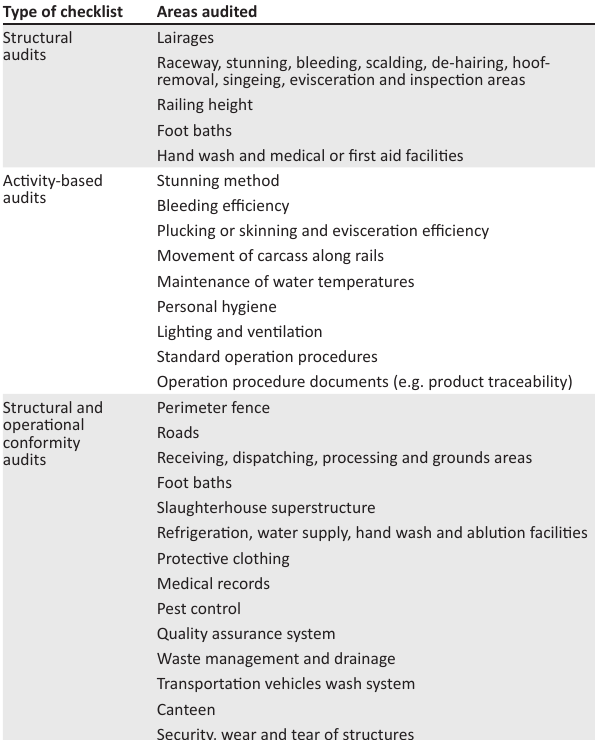
TABLE 1: Checklists used on slaughterhouse audits in the five selected abattoirs.